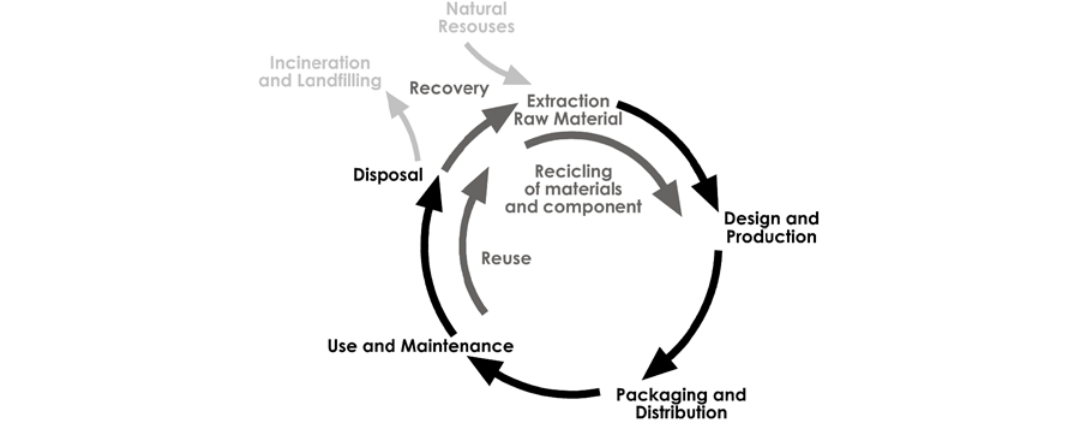
Figure 1. “Life Cycle Thinking”. Source: